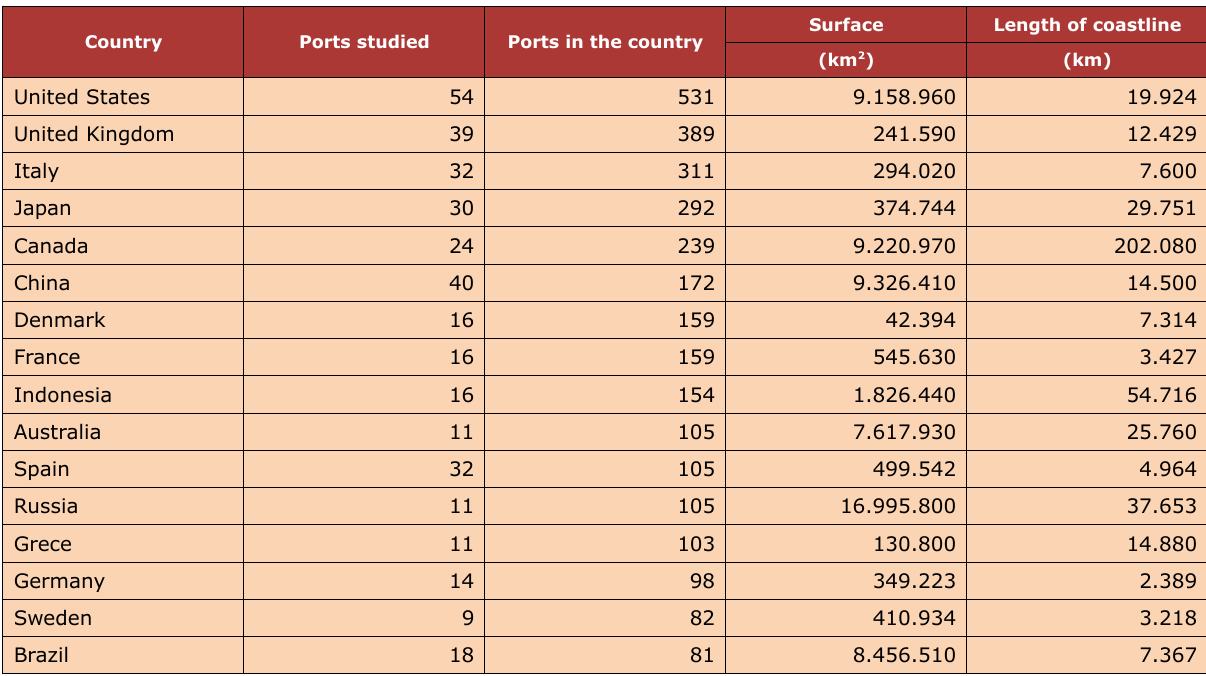
Table 1. Geographical data of the countries with the highest number of